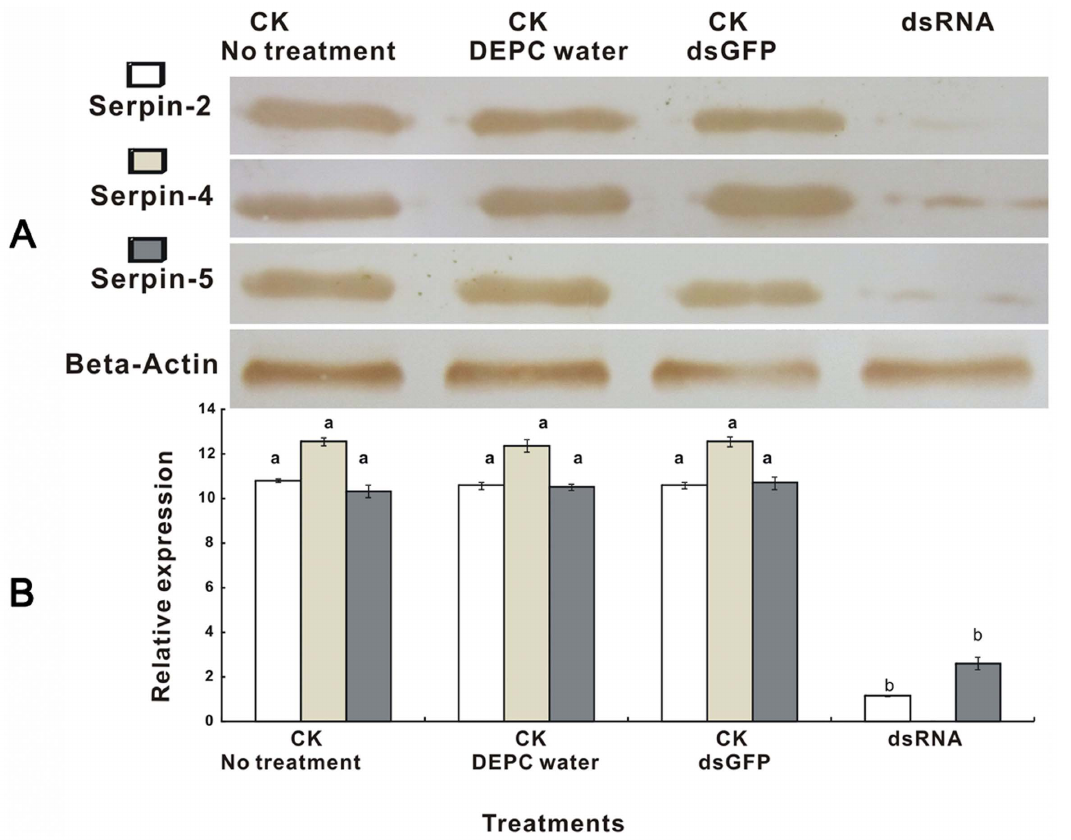
Figure 7. Detection of the efficiency of RNAi and impact on serpin-2, serpin-4 and serpin-5 mRNA levels by Western Blot (A) and qRT-PCR (B). The mRNA and protein levels were normalized relative to the b -Actin. The different letters above the columns indicate significant differences in serpins genes expression during P. xylostella development ( P , 0.05). Each point represents mean value 6 S.E.M of three independent experiments with three individuals in each replicate. Western Blot analysis visualized by